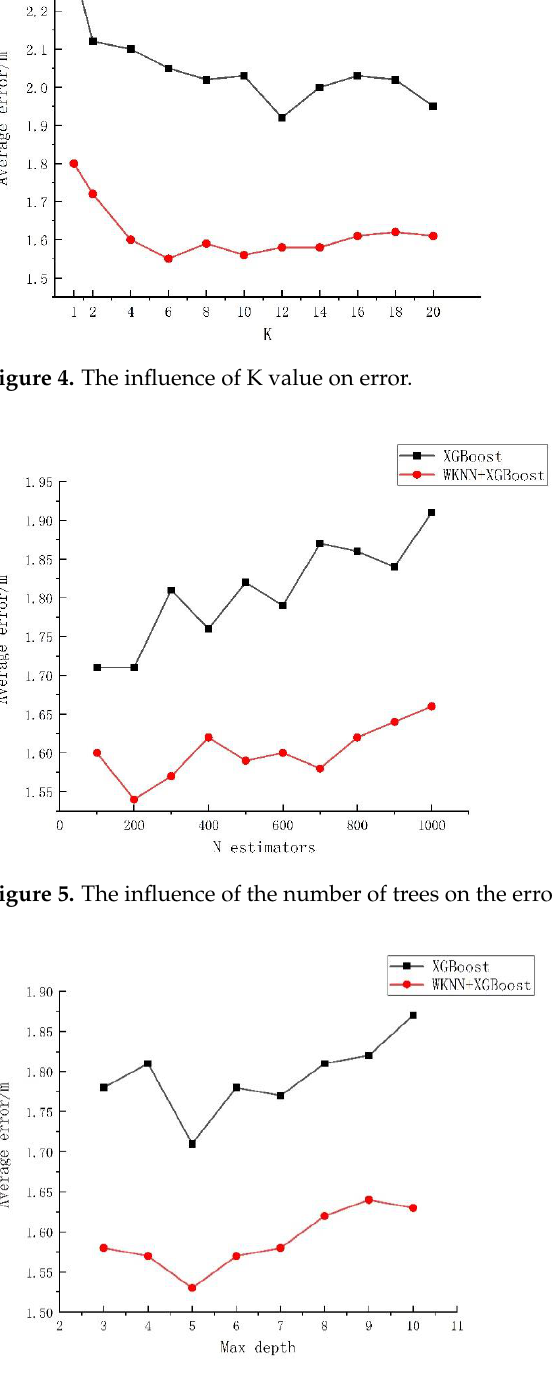
Figure 7. The influence of learning rate on error. As shown in Figure 4, when the K value varied within 1 – 20, the average positioning error of the WKNN algorithm was 1.92 – 2.31 m, with a fluctuation of 26.39%. The average positioning error of WKNN and XGBoost algorithms was 1.55 – 1.8 m, with an overall fluc- tuation of 11.43%. As shown in Figure 5, when the number of regression trees varied within 100 – 1000, the average positioning error of the XGBoost algorithm was 1.71 – 1.91 m, fluctuating by 10.47% as a whole, and that of the WKNN and XGBoost fingerprint posi- tioning algorithms was 1.54 – 1.66 m, with an overall fluctuation of 8.82%. As shown in Figure 6, within the decision tree depth of 3 – 10, the average positioning error of the XGBoost algorithm was 1.72 – 1.88 m, with an overall fluctuation of 8.51%, and that of the WKNN and XGBoost algorithms was 1.53 – 1.64 m, with an overall fluctuation of 7.23%. As shown in Figure 7, as the learning range changed within 0.01 – 0.35, the average posi- tioning error of the XGBoost algorithm was 1.68 – 1.95 m, with an overall fluctuation of 13.85%, while that of the WKNN and XGBoost algorithms ranged from 1.48 to 1.73 m, with an overall fluctuation of 14.37%. From the above experiments, it could be seen that the K value exerted a great influence on the WKNN+XGBoost positioning algorithm, with an influencing degree of 11.43%. Within the empirical value interval, moreover, the change in learning rate reached the highest influencing degree of 14.37%, and the influ- encing degree of the change in decision tree depth was 7.23% while that of the change in the number of regression trees reached 8.82%. During parameter optimization, therefore, the focus could be on optimizing the K value and learning rate. According to the above experimental results, the initial settings for the basic parameters of the KNN, WKNN,